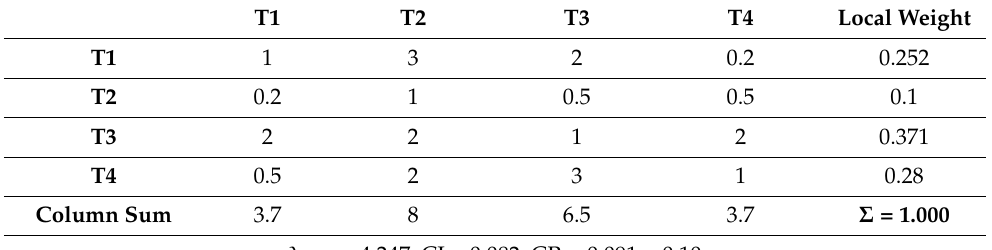
Table 13. Pairwise comparison matrix for “Threats” category.